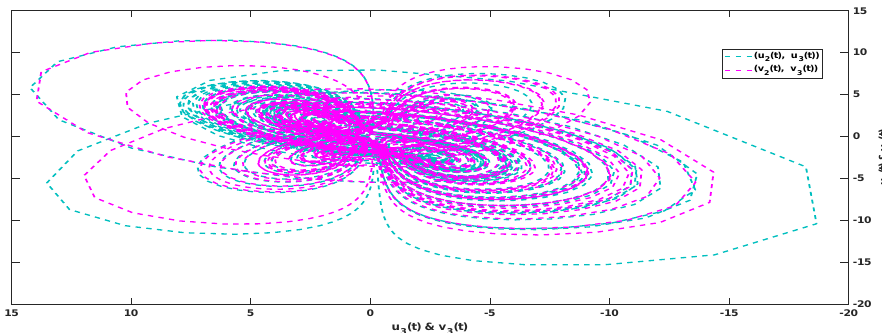
Figure 7. Chaotic behavior of the states ( u 2 ( t ) , u 3 ( t )) and ( v 2 ( t ) , v 3 ( t )) of the drive-response systems (13) and (14) with fractional order q = 0.9, respectively.